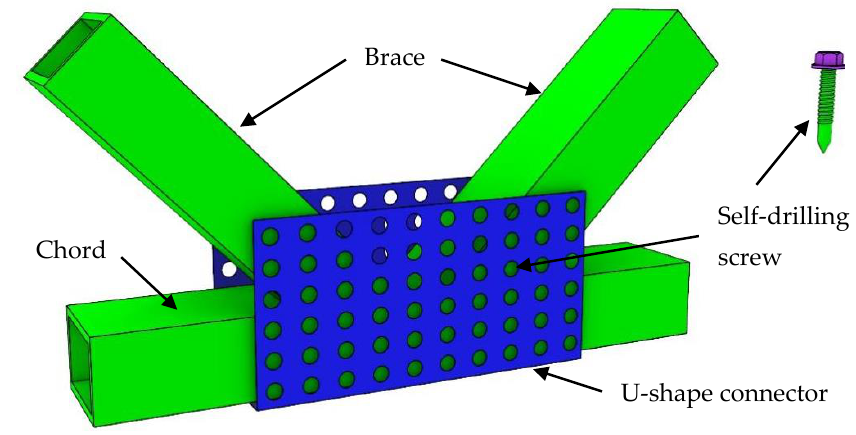
Figure 1. Proposed K-joint.